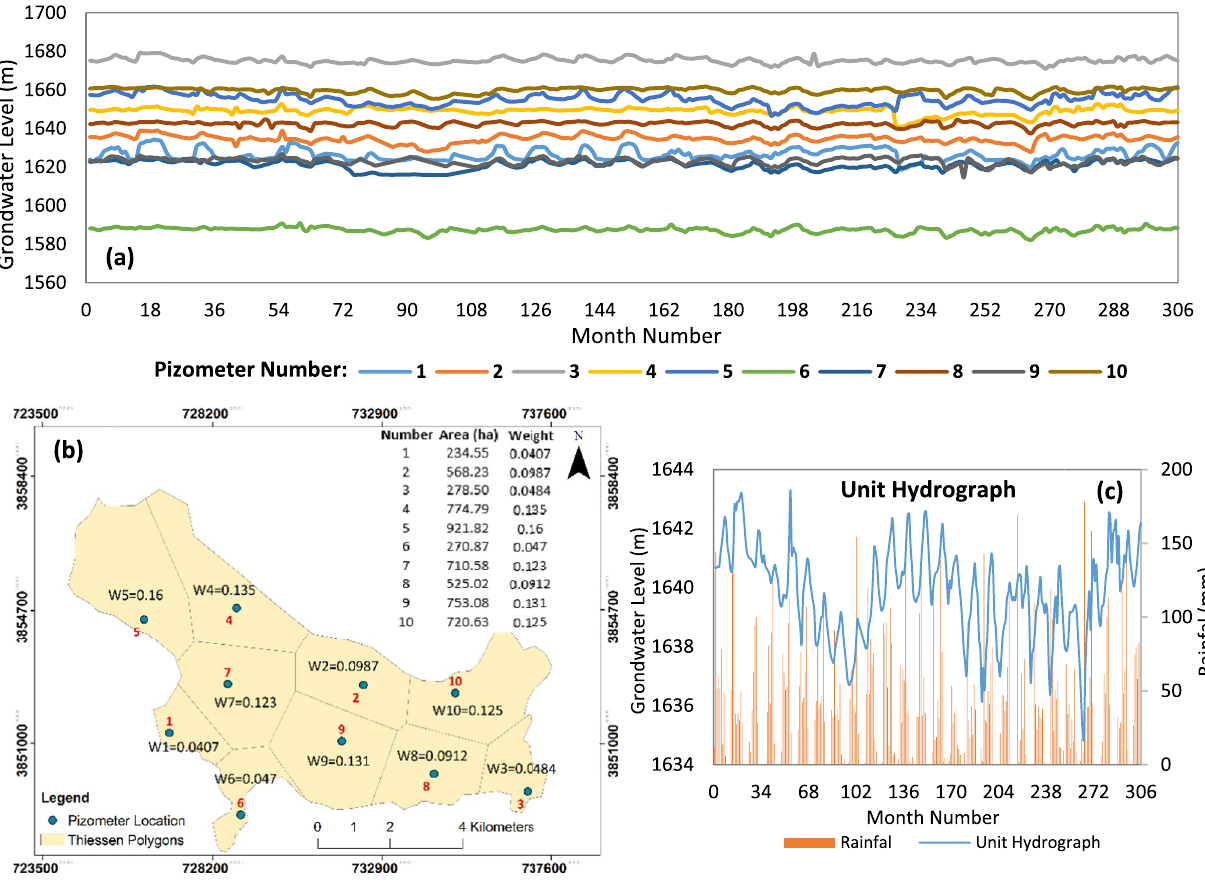
Fig. 2 a Fluctuations of GWL in each of the piezometers in the plain b Thiessen polygons and weight of each piezometer c unit hydrograph of groundwater (m) and rainfall (mm) in the whole study period in the